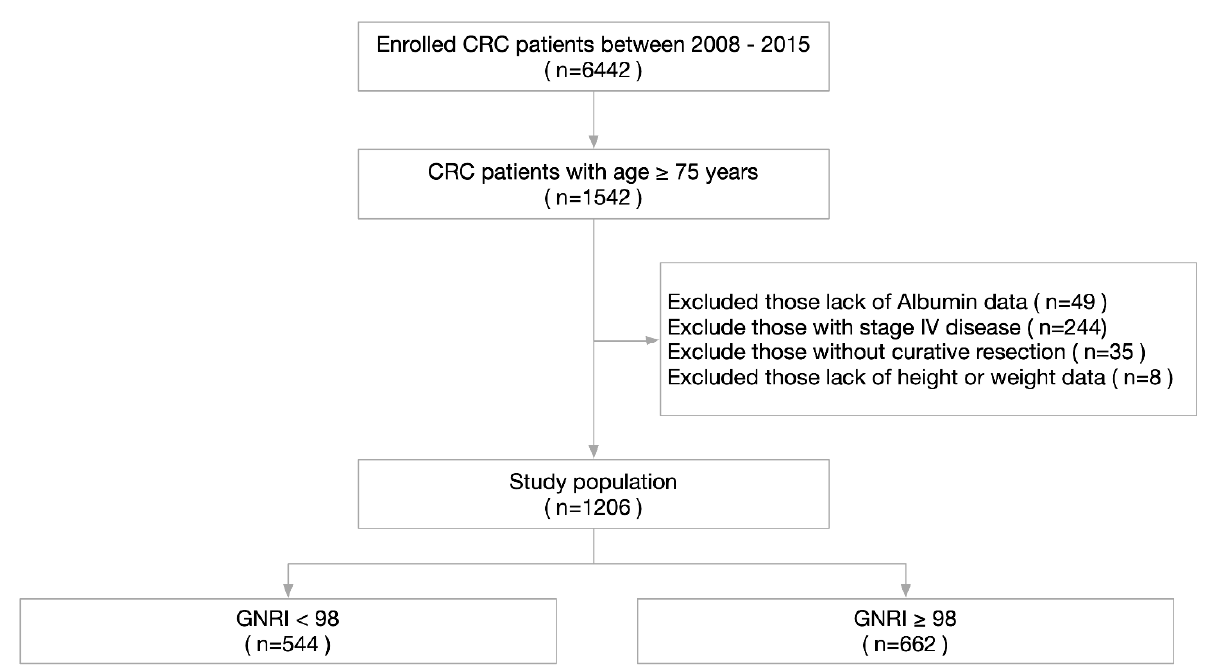
Figure 1. The flowchart illustrating the clinical patient selection in this study.